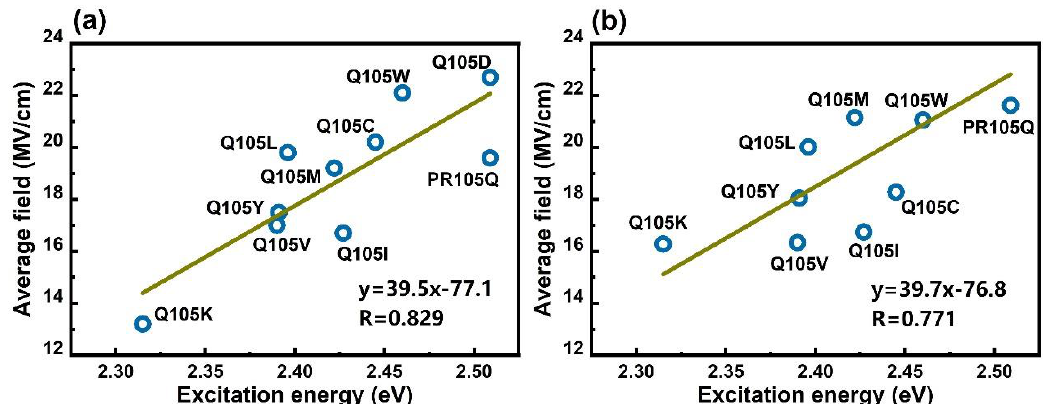
Figure 7. Correlation between the average electric field of 100 snapshots taken from QM/MM MD simulation trajectory for PR105Q and nine mutants, and the calculated 1B QM excitation energy by EE-GMFCC. ( a ) The average electric field calculated by the Amber ff14SB charge model. ( b ) The average electric field calculated by the PPC charge model.